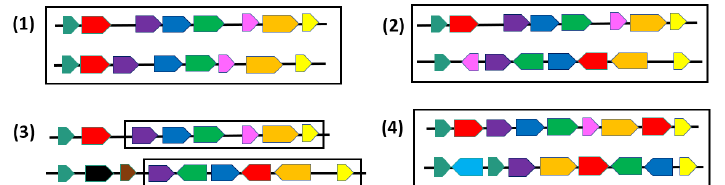
Figure 2. Pairs of regions where genes (or blocks) of the same family are represented by the same color. ( 1 ) Two identical permutations; ( 2 ) Two common intervals; ( 3 ) A δ -team (maximum chain of common genes separated by at most δ foreign genes) with δ = 1; ( 4 ) Two gene orders on different alphabets and with gene